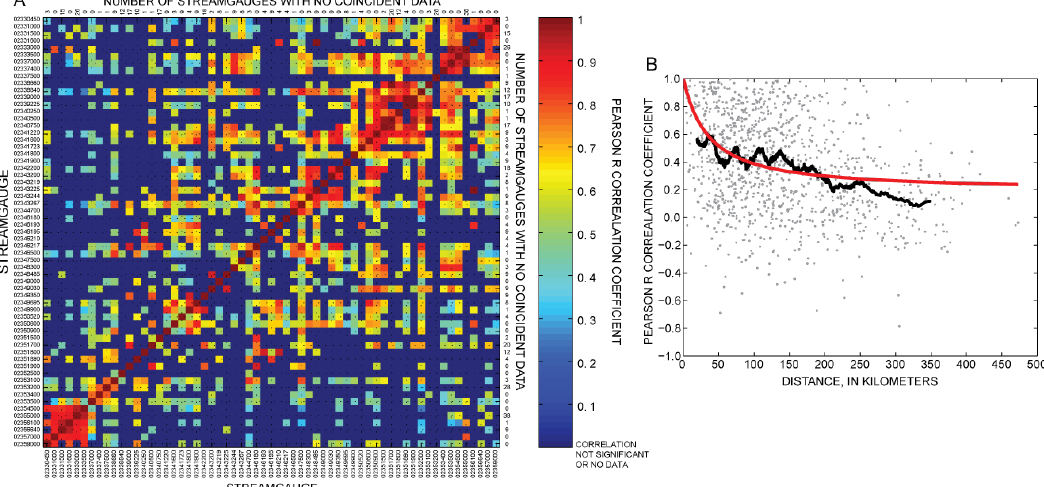
Fig. 8. (A) shows the correlation matrix of the annual flood series between each pair of the 61 study streamgauges. The values on the upper right of the matrix show the number of pairs for which there was no coincident data to compute the correlation between the annual flood series or the correlation was not significant at the p = 0 . 05 level. (B) shows empirical cross-correlation coefficients for couples of catchments (dots), a moving weighted-average curve that weights empirical values proportionally to the record length (black line) and the Tasker and Stedinger (1989) model fitted to data (red